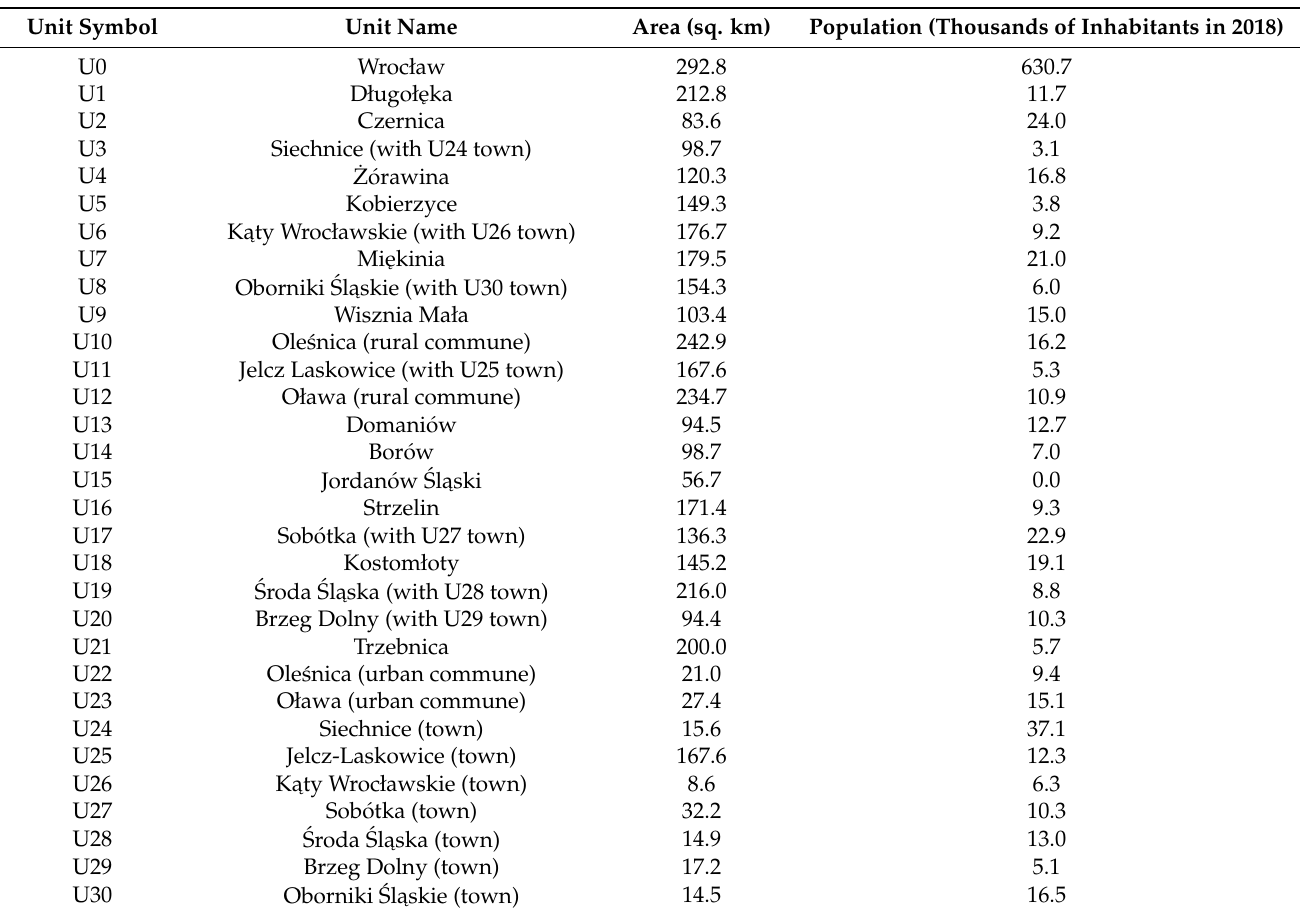
Table 1. Basic data on the examined administrative